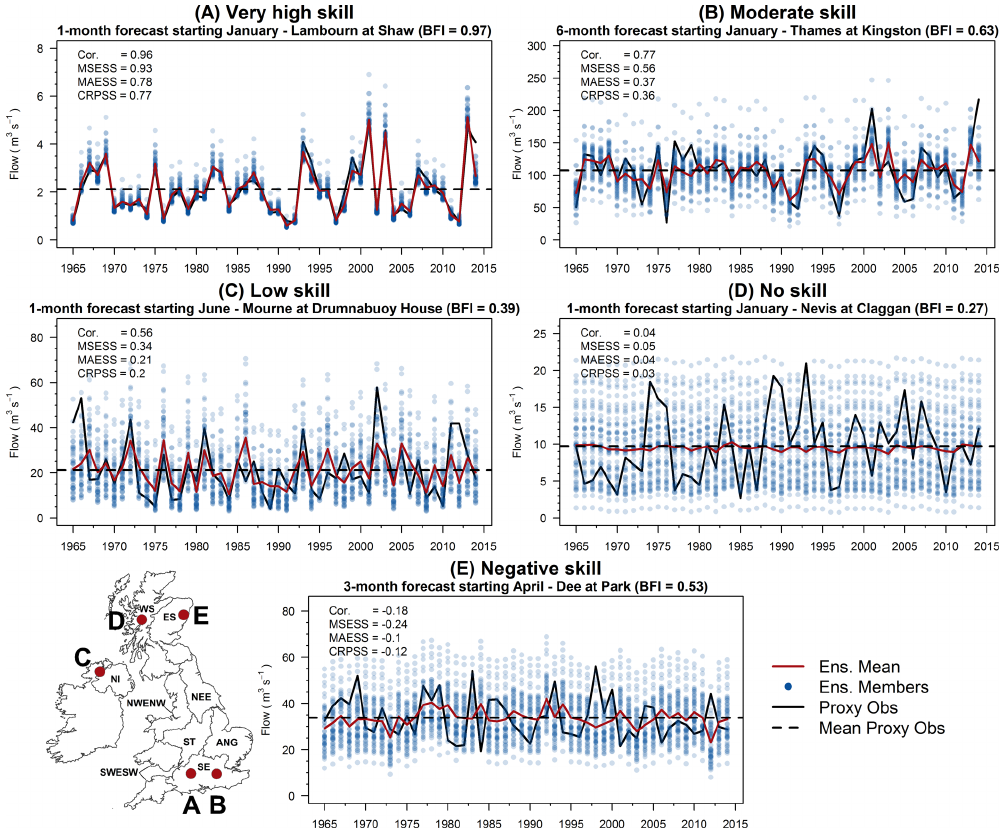
Figure 2. Five example 1965–2015 hindcast time series in which skill metrics range from very high (a) to negative skill (e) . The red line is the 51-member ESP ensemble mean, black line the proxy observed streamflow (also known as a perfect forecast), semi-transparent blue dots show the ensemble spread for each hindcast year, and the dashed horizontal black line shows mean proxy observed streamflow (analogous to a deterministic climatology benchmark forecast, although not cross-validated here as was done in calculation of skill scores (i.e. simply the same value repeated each